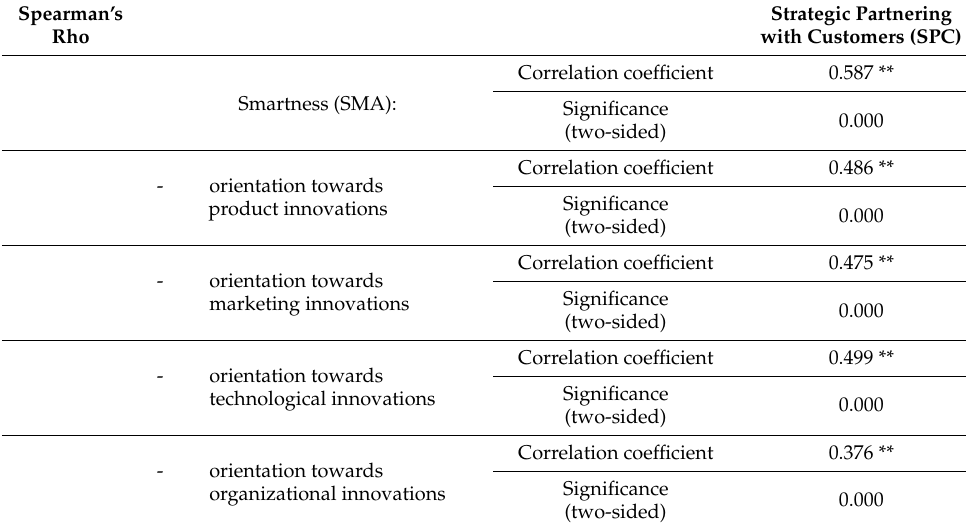
Table 5. Correlation between SMA and SPC ( n =157).